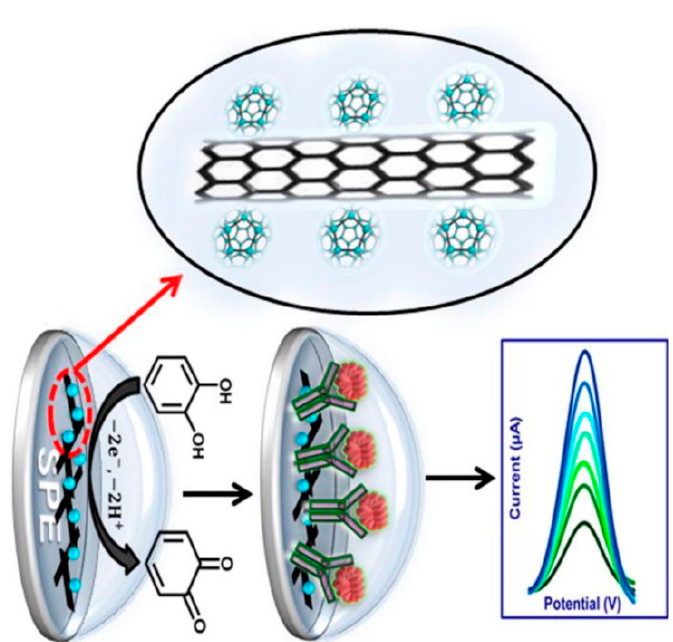
Figure 4. Schematic representation of Fullerene-Functionalized Carbon Nanotubes/Ionic Liquid based label-free electrochemical immunosensor. Reprinted with Permission [75].